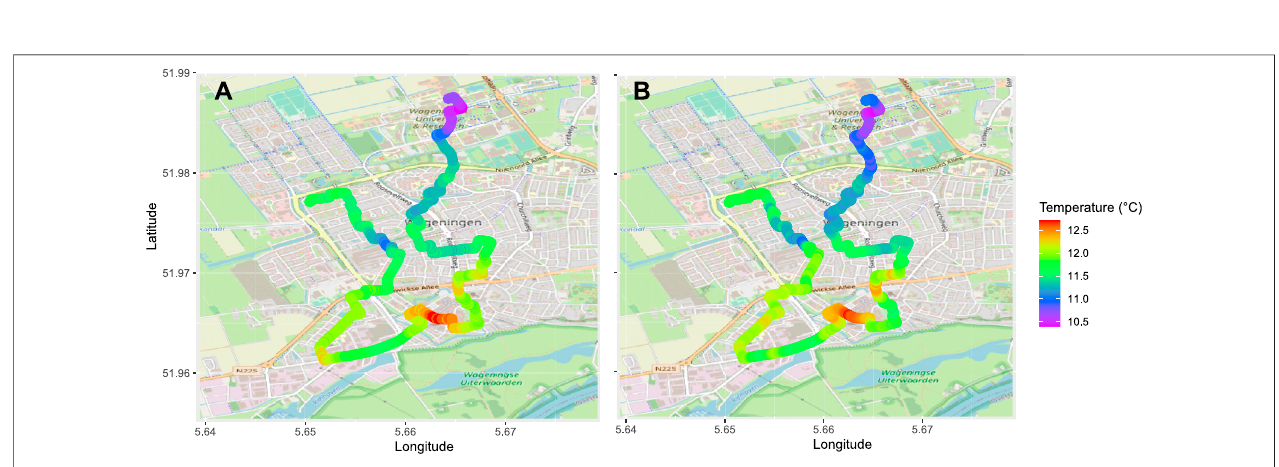
FIGURE12| Bias corrected transect measurementsofairtemperature,measured from smartphone observations (A) andthe measurementtricycle (B) . Datawas measured on the same instance as Figure 11 , and has been bias corrected before plotting.